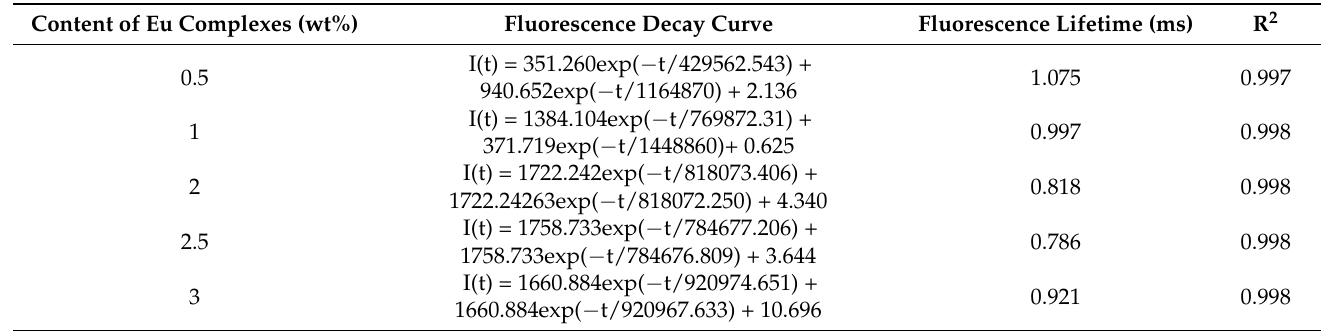
Table 1. Fluorescence decay curve and lifetime of polyurethane–europium materials with different mass contents of europium